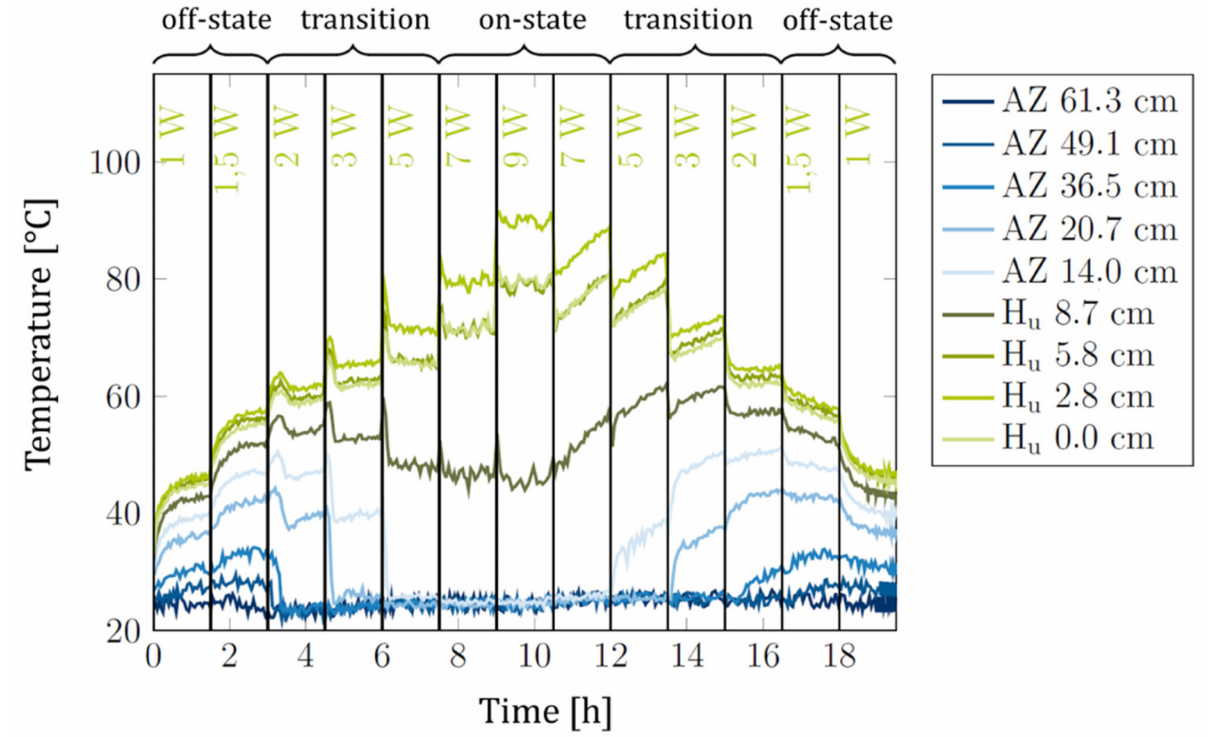
Figure 4. Siphon-1 with 4 g of sorbent: Temperatures measured along the heat switch versus time. Blue lines: Temperatures in adiabatic zone (AZ). Green lines: Temperatures in heater area (H u ). The legend indicates the thermocouple positions along the heat switch, going down from the upmost thermocouple near the condenser to the downmost thermocouple at the evaporator bottom at 0.0 cm. The respective heat power is indicated below the upper x -axis. Each heat power was held for 90 min. At the top, the regime of operation is indicated (the regimes of operation are explained